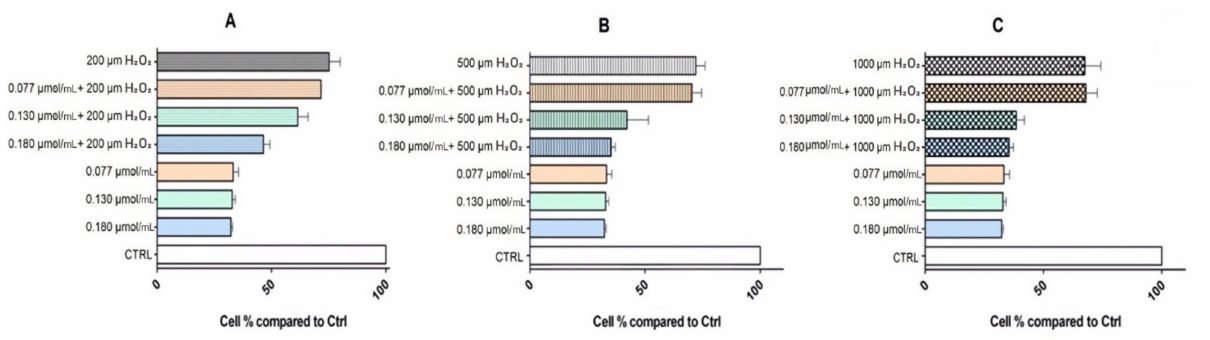
Figure 8. ( A ) Flow-cytometry analysis of HaCaT cells following exposure to rhodoxanthin. ( B ) Flow- cytometry analysis of B16F10 cells following exposure to rhodoxanthin. Values represent the mean ± SD of three samples.